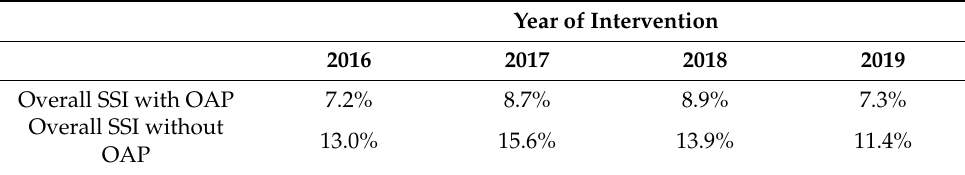
Table 6. Trends in the effect of OAP on overall SSI during the study